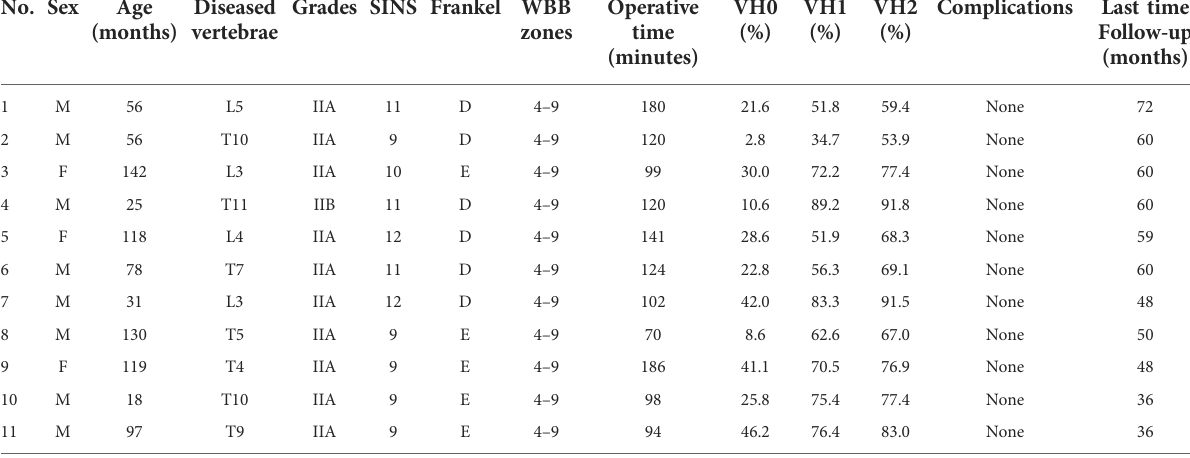
TABLE 3 Clinical details of the historical